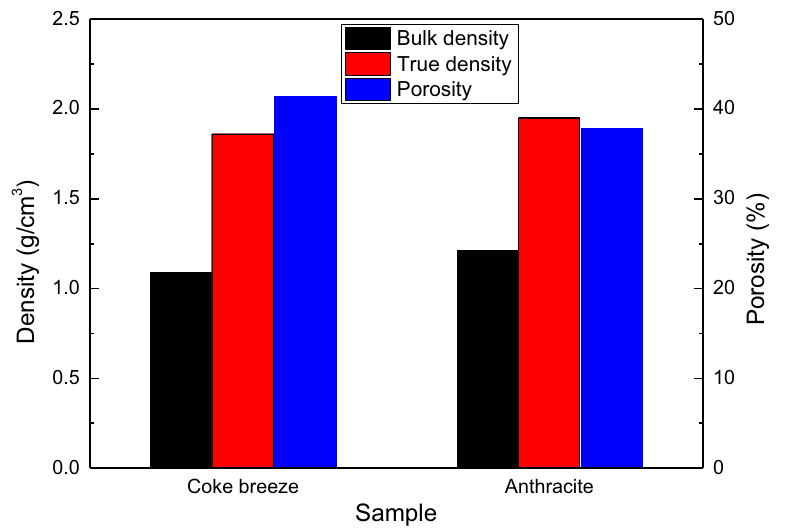
Figure 3. Densities and porosities of the coke breeze and